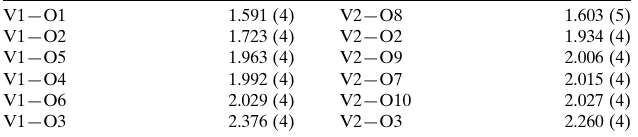
Selected bond lengths (A˚ ).